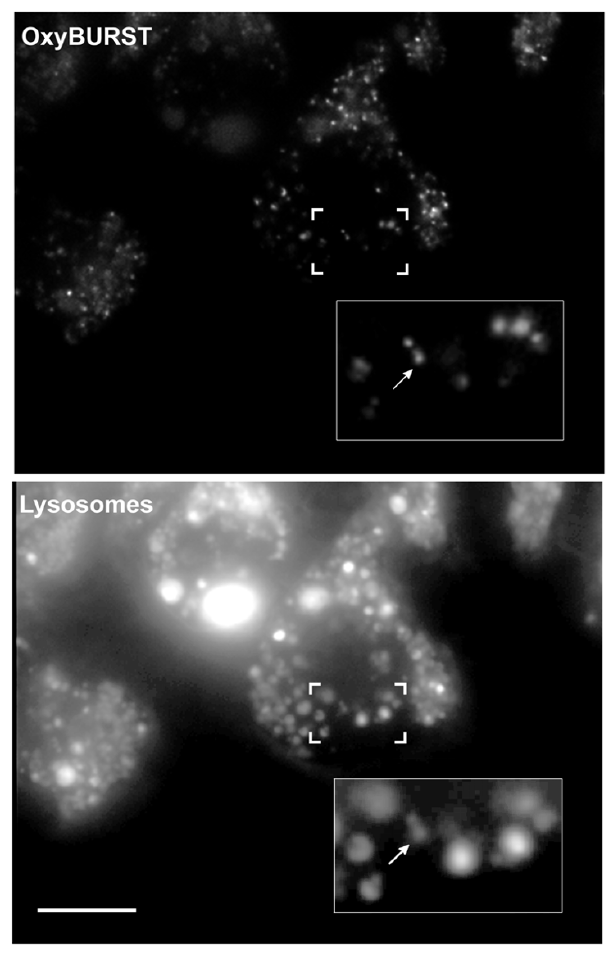
Figure 2 Oxidized OxyBURST Green H 2 HFF BSA distributes in a subset of lysosomes. The Cascade Blue-conjugated dextran was used as a lysosomal marker, and staining of Oxy- BURST Green H 2 HFF BSA in PMA-treated cells was per- formed as described in the Methods section. The area of a cell (indicated by the bracket) was enlarged for comparison, as shown in the inset of each panel. As indicated by the arrows, oxidized dye preferentially accumulates in a subset of lysosomes. Bar, 10 µ